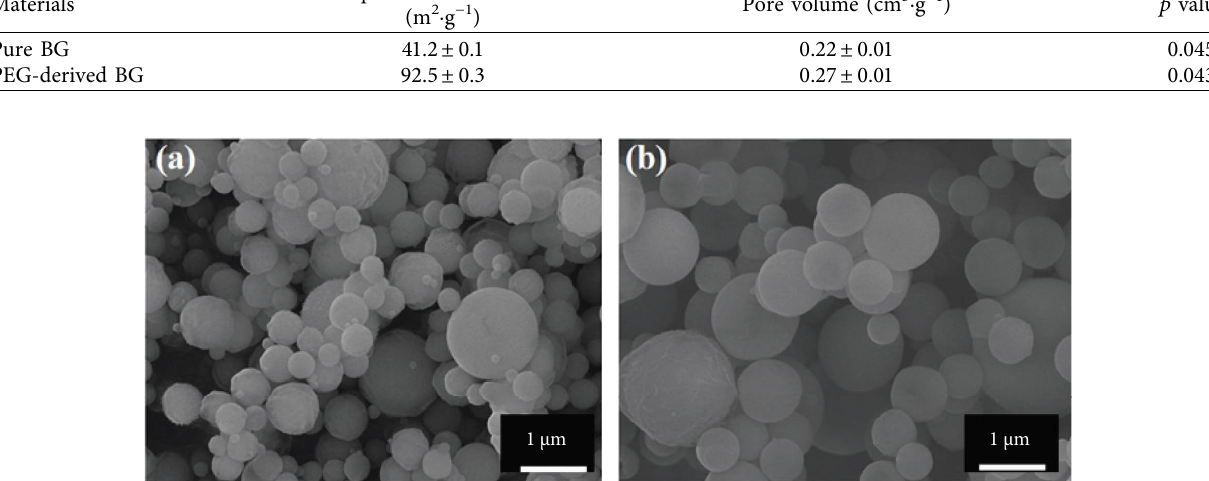
Figure 2: Surface morphology of (a) pure BG powder and (b) BG-derived PEG powder.